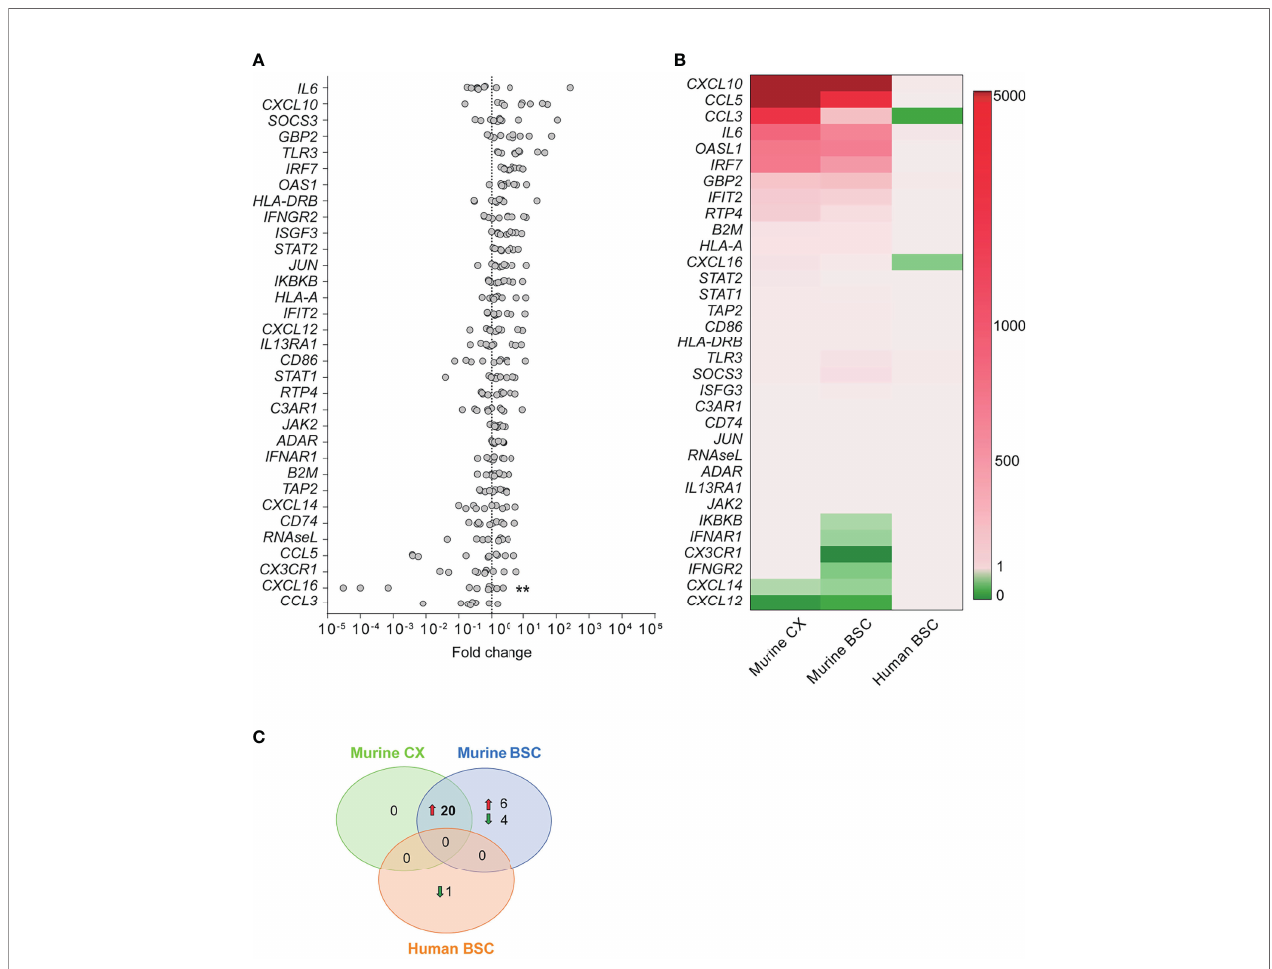
FIGURE 3 | Human transcription pro fi le upon RABV infection. (A) Gene expression fold changes in post-mortem brain biopsies of the BSC of rabid patients (n=10) normalized to non-rabid patients (n=4). Differential expression was calculated by comparing the gene expression ( D CT values) between rabid patients (n=10) and non-rabid (control) patients (n=4) by using the S ̌ ı ́ da ́ k ’ s multiple comparisons test (** adjusted p-value < 0.01). A detailed overview of the differential gene expression analysis can be found in Supplementary Table S4 . (B) Heatmap comparing the expression of in fl ammatory genes between RABV Tha strain-infected murine CX (n=6) and BSC (n=6), and RABV-infected human BSC (n=10). Heatmap presents gene expression fold changes calculated from normalized gene expression values ( DD CT) of infected animals and humans to the respective non-infected controls (murine CX [n=6]; murine BSC [n=6]; human BSC [n=4]). Gene names are indicated in the human gene name nomenclature although expression indicates quanti fi cation of human or murine genes depending on the tissue investigated. (C) Number of differentially expressed genes showing the same tendency (up- or downregulation) in the RABV Tha strain-infected murine CX (n=6) or BSC (n=6), and RABV- infected human BSC (n=10). Differential gene expression was calculated to non-infected mice (n=6) or human controls (n=4), respectively. A detailed overview of the differential gene expression analysis can be found in Supplementary Table S4